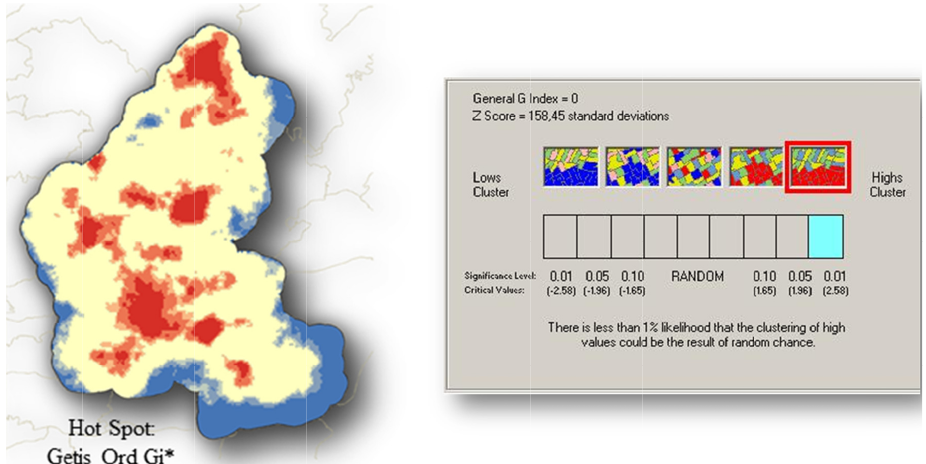
Fig. 6. Local spatial autocorrelation – Hot spot analysis (Getis–Ord Gi ∗